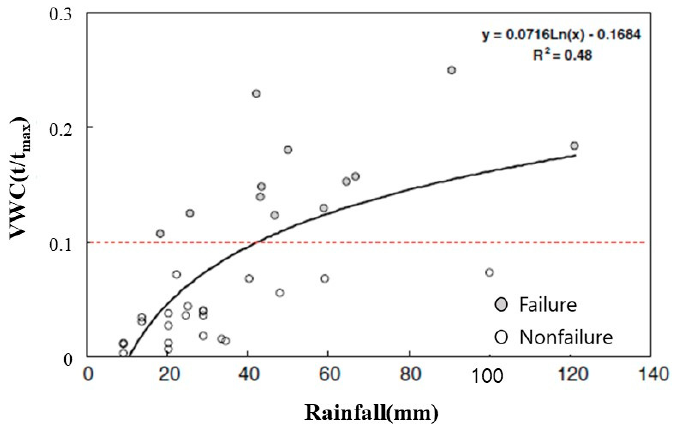
Figure 2. Relationship between the VWC gradient and rainfall (Reprinted with permission from ref. [21]).